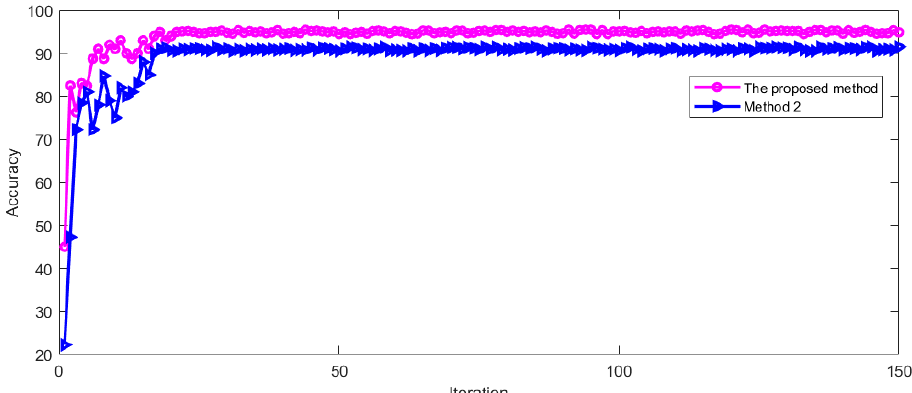
Figure 18. The accuracy comparison of two methods in training process.